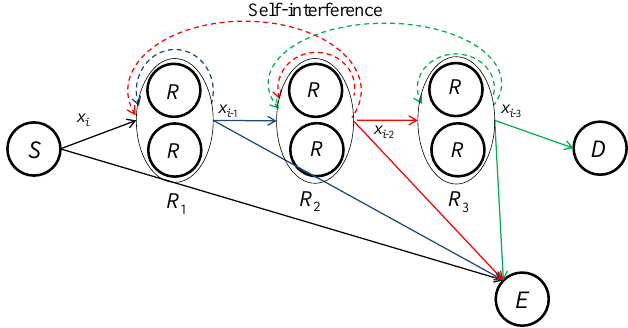
Figure 1. Illustration of a full-duplex multi-hop decode-and-forward (DF) relay network with N = 3, T 1 = T 2 = T 3 = 2, and T E =